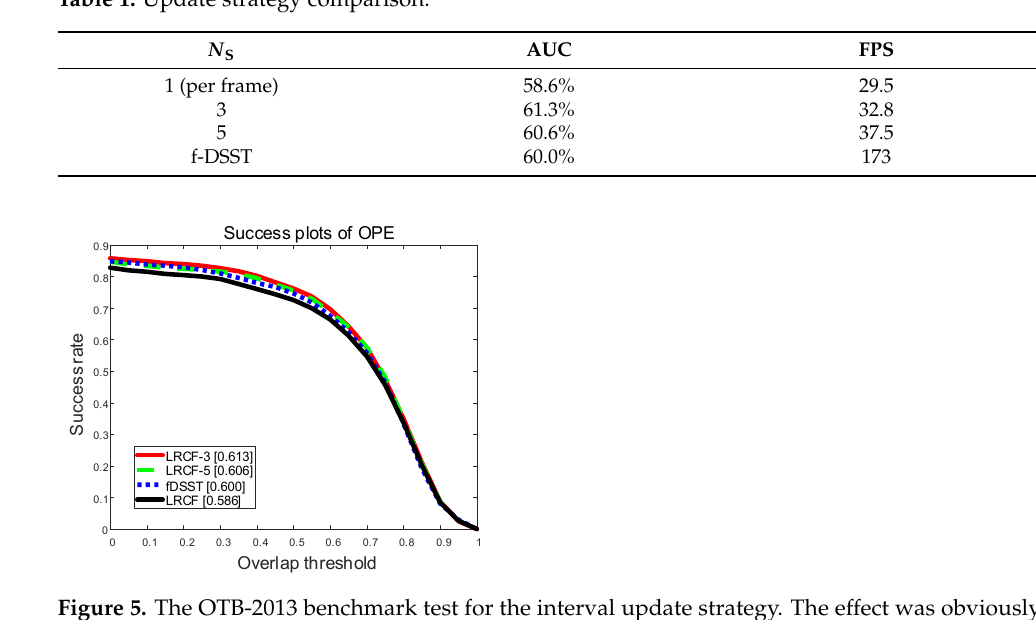
Table 1. Update strategy comparison.